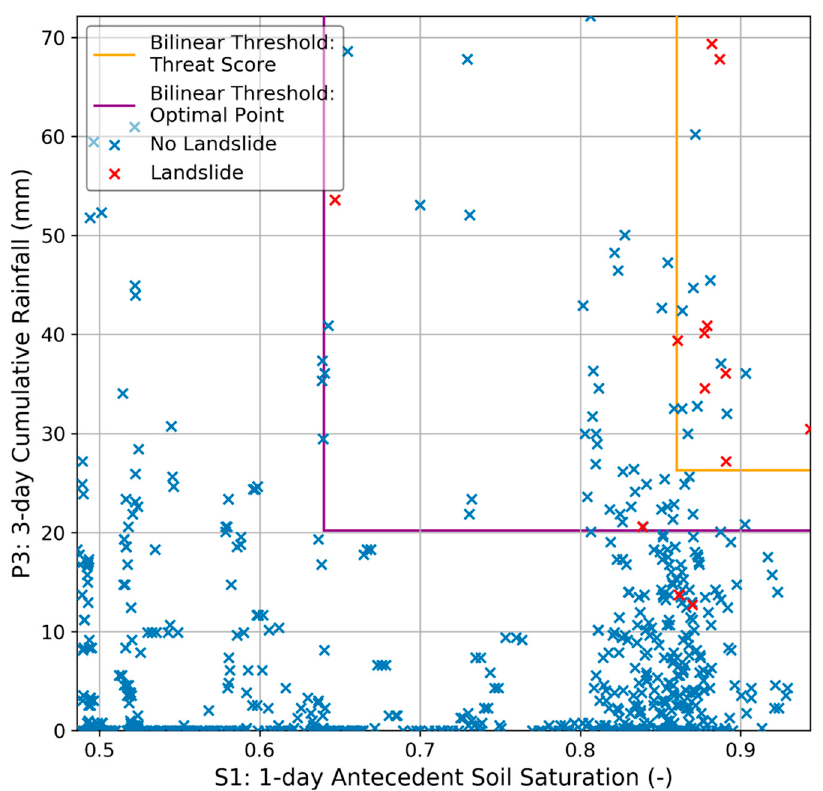
Figure 9. HydroMet output plot showing dual-threshold analysis for Mukilteo, Washington, using a P3:S1 daily threshold. For both skill statistics, threat score and optimal point, a range of threshold values were tested to find the optimal threshold, shown above. Only landslide events and non- landslide events are shown since the determination of a missed alarm is dependent upon which skill statistic is used.